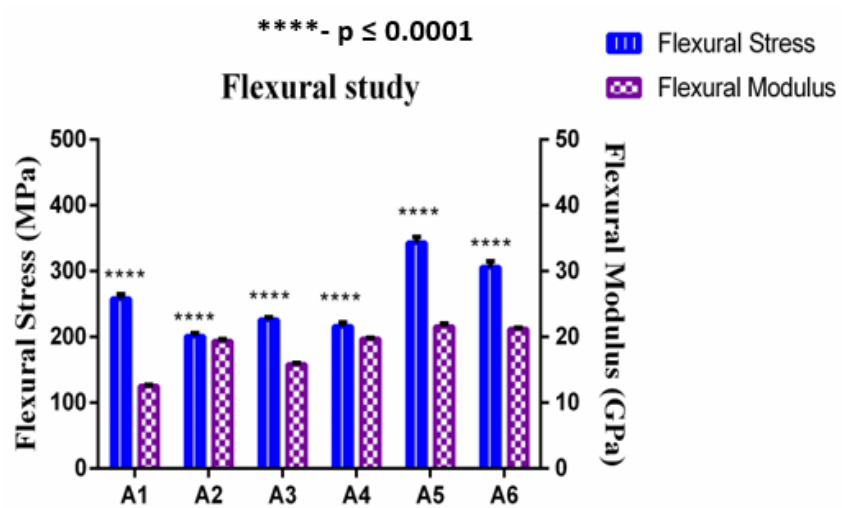
Figure 5. Flexural modulus vs. flexural strength of GF / SF / CTS composite sca ff olds. Data are represented as means of triplicate (n = 3) ± SD, where **** indicates p ≤ 0.0001.